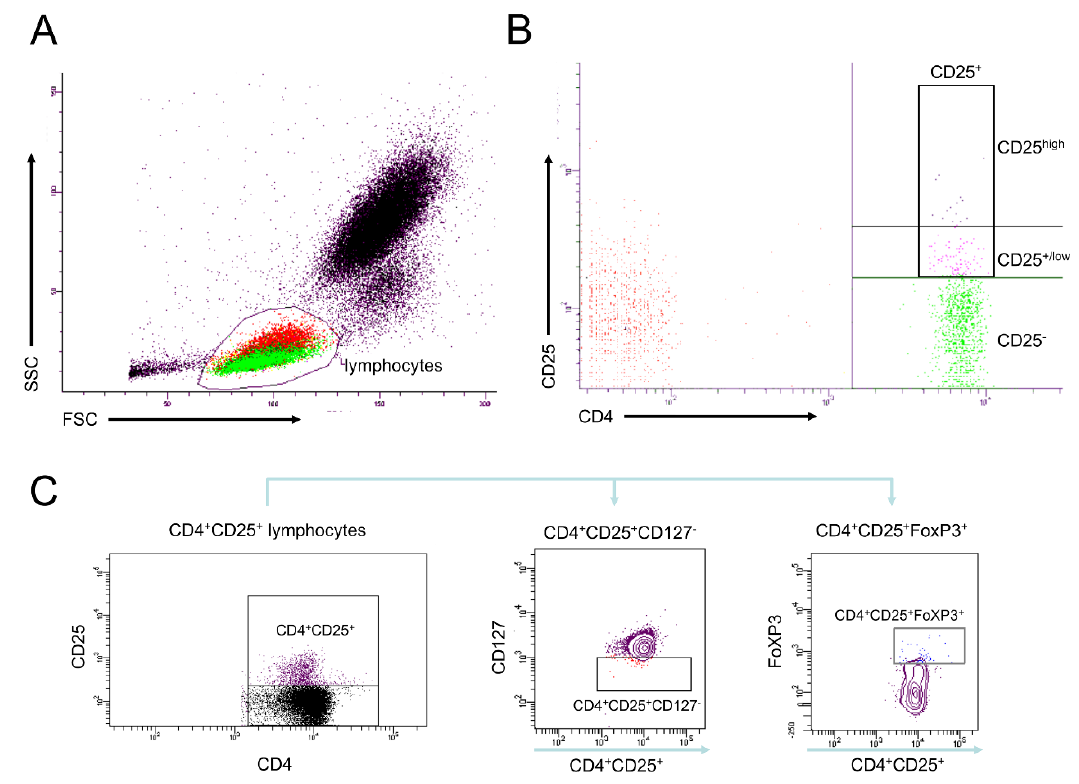
Figure 1. Gating strategy for the flow cytometric analysis. ( A ): Gating of the lymphocyte fraction in peripheral blood according to the forward and side scatter. ( B ): Gating for the detection of CD4 + CD25 + cells. ( C ): Gating of the lymphocytes according to their CD4 and CD25 expression and subsequently of CD127 and FoxP3 expressing cells.